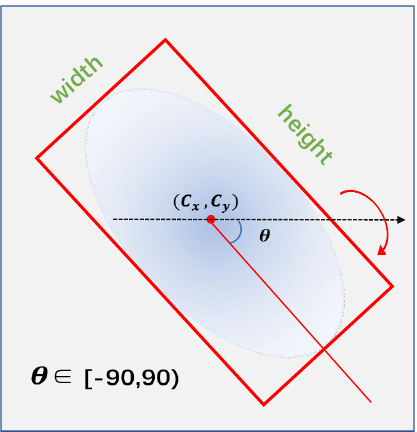
Figure 3. Five-parameter long side-based representation for oriented objects.